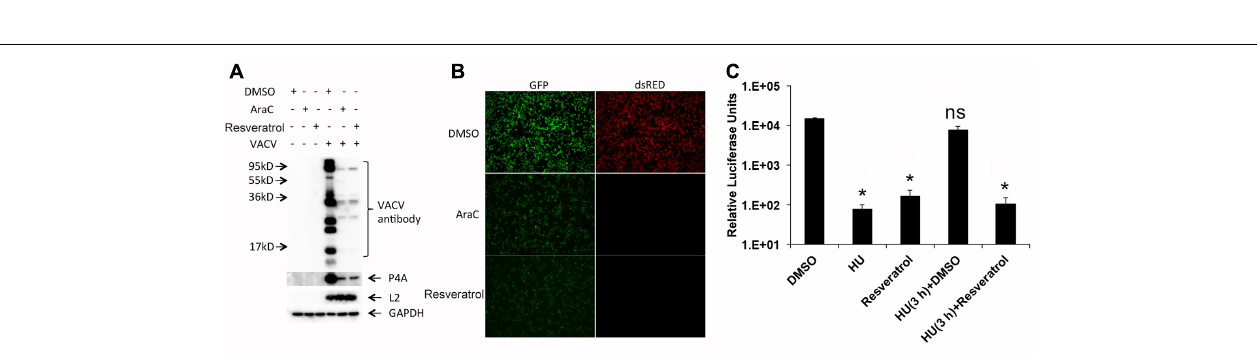
FIGURE 4 | Resveratrol suppresses N1L-deleted VACV replication. (A) Deletion of N1L gene from recombinant virus was confirmed by PCR with two pairs of primer specific for C11R gene (positive control) and N1L gene, respectively. (B) HeLa cells were infected with wild type and N1L-deleted VACV at an MOI of 1. Virus growth was determined by a plaque assay. (C) HeLa cells were infected with N1L-deleted VACV at an MOI of 1 in the presence or absence of resveratrol (50 µ M). Virus titers were determined by a plaque assay at 24 hpi. The asterisk indicates significant difference ( P < 0.05). The error bar indicates standard deviation.